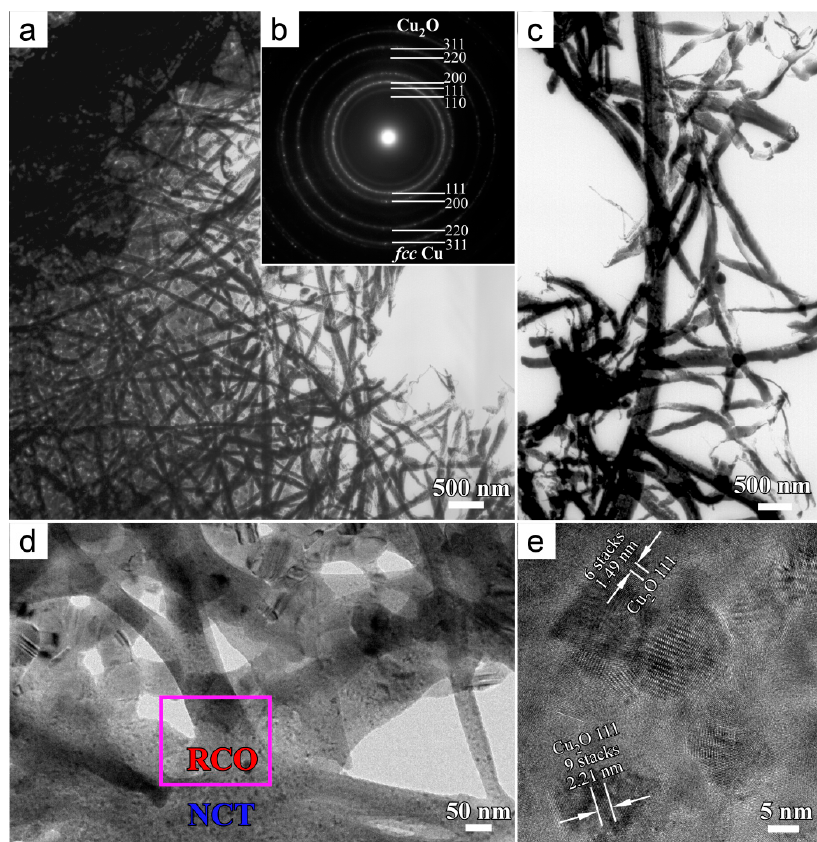
Figure 5. BFI ( a , c ), SADP ( b ), high-magnified cross-sectional transmission electron microscope (TEM) image ( d ) and corresponding HRTEM image ( e ) of Cu 2 O nanobelts formed on the surface of the nanoporous Cu after free immersion in ethanol for 72 h (RCO: Root of Cu 2 O nanobelts; NCT: Nanoporous copper templates).